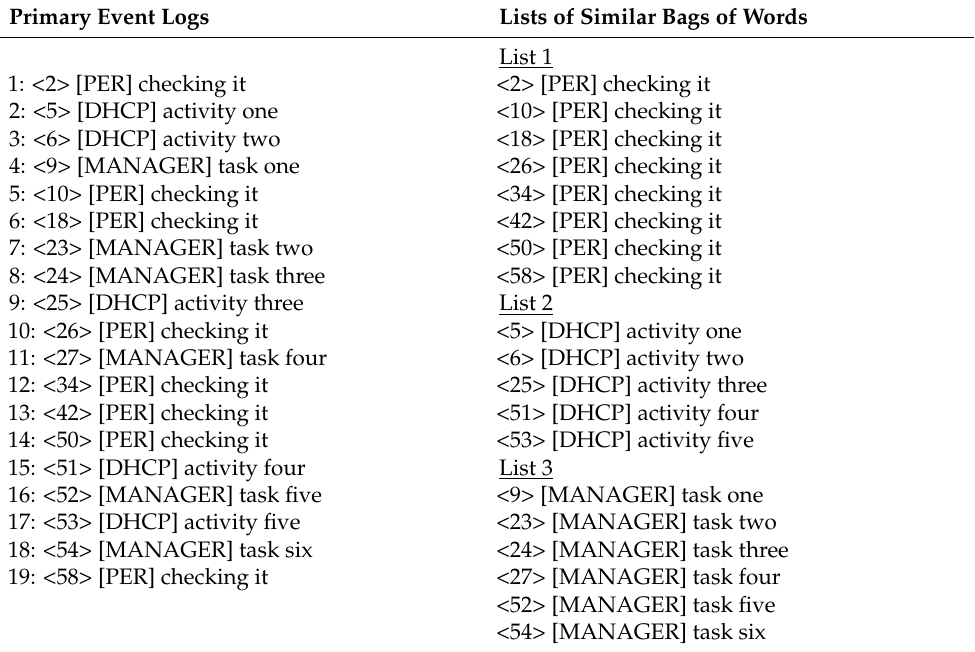
Figure 2. Excerpt of power supply plot for Holter device. Table 1. Excerpt of event